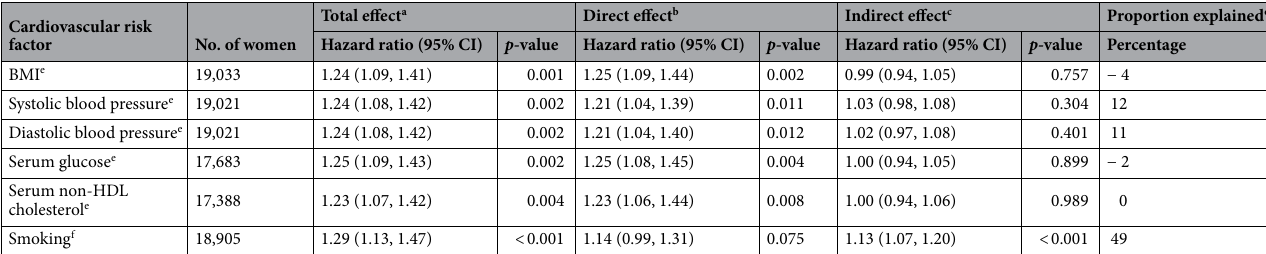
Table 4. Decomposition of the association between history of SGA offspring and cardiovascular disease into direct and indirect effects. a Association between history of SGA offspring and CVD compared to women with history of appropriate for age offspring. Hazard ratio differs from that in Table 2 due to additional adjustment for age of mediator ascertainment. b Part of the association between history of SGA offspring and CVD that is not explained by the cardiovascular risk factor. c Part of the association between history of SGA offspring and CVD that is explained by the cardiovascular risk factor. d Proportion excess cardiovascular risk in women with history of SGA offspring that is explained by cardiovascular risk factor. e Estimates are adjusted for age (used as time scale in the Cox proportional hazards model), age at measurement of the cardiovascular risk factor, highest obtained educational level, age at first birth, parity, first birth in the Medical Birth Registry of Norway, maternal height and birth year. f Estimates are adjusted for age (used as time scale in the Cox proportional hazards model), highest obtained educational level, age at first birth, parity, first birth in the Medical Birth Registry of Norway, maternal height and birth year. SGA small for gestational age, CVD cardiovascular disease, CI confidence interval, BMI body mass index, HDL high-density